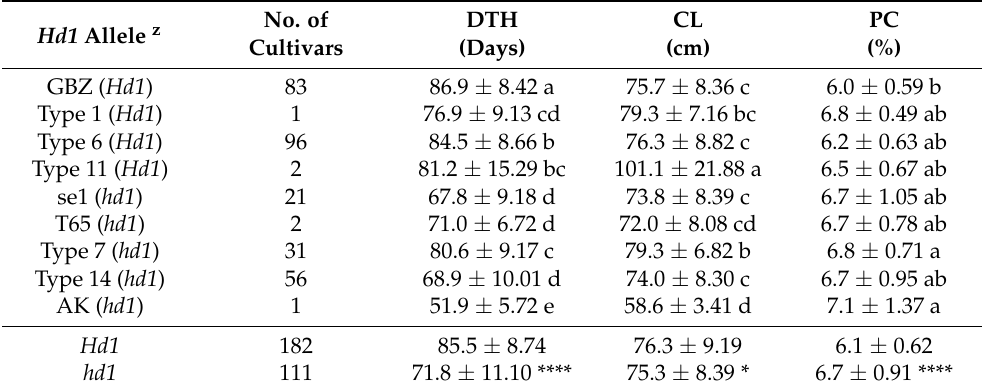
Table 3. Mean comparisons of days to heading (DTH), culm length (CL), and protein content (PC) according to Hd1 allele types in 293 Korean rice